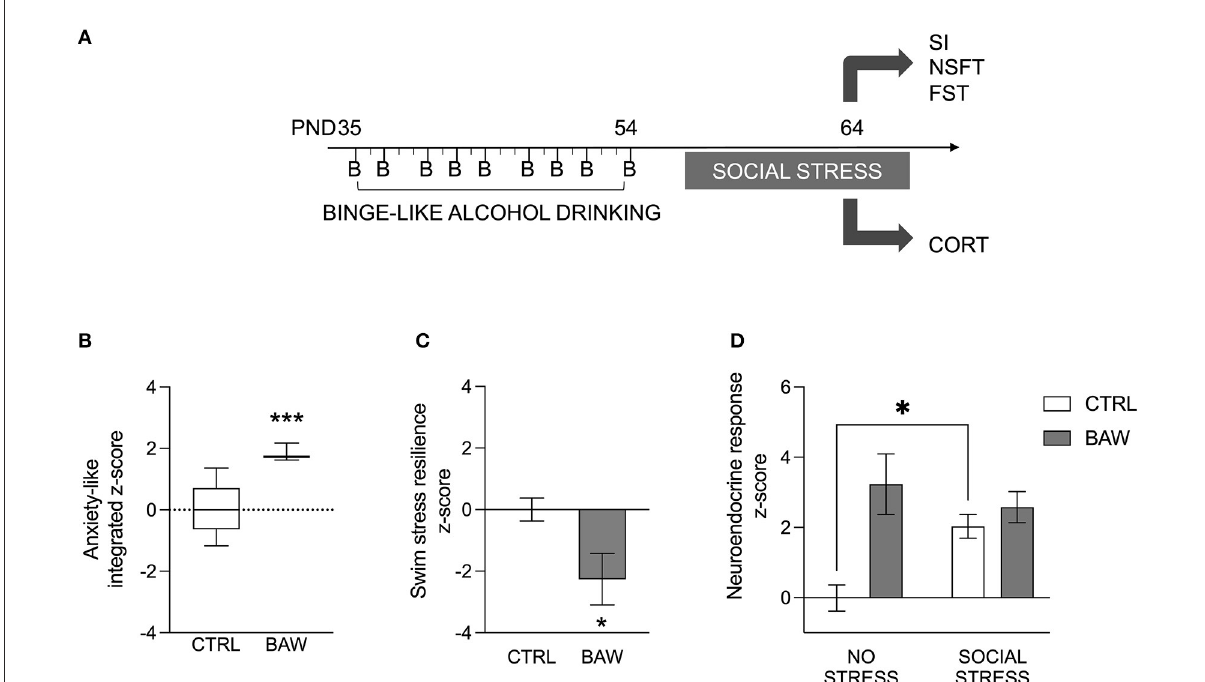
FIGURE3 Anxiety-like phenotype and stress reactivity in the rat model of binge-like alcohol exposure. Alcohol binge drinking during adolescence was modeled in rats in order to assess anxiety-like phenotype and stress reactivity (A) . Altered anxiety-like phenotype and stress reactivity in the rat model of binge-like alcohol exposure. Rats exposed to binge-like alcohol during adolescence displayed a higher integrated z -score referring both to anxiety-like behavior under social or novel circumstances than CTRL rats (B) . When the active coping to the swim stress was evaluated as a measure of resilience, BAW rats displayed a lower score than the CTRL group (C) . Moreover, binge-like alcohol exposure altered the neuroendocrine stress response in adolescent rats. In detail, when CTRL rats were exposed to social stress, they displayed increased CORT serum levels, with respect to basal levels; on the other hand, no significant increase was observed in BAW rats (D) . Data are shown as the mean ± SEM. * p < 0.05; *** p < 0.001. CTRL, control group; BAW, binge-like alcohol-exposed rats; SI, social interaction test; NSFT, novelty suppressed feeding test; FST, forced swimming test; CORT,